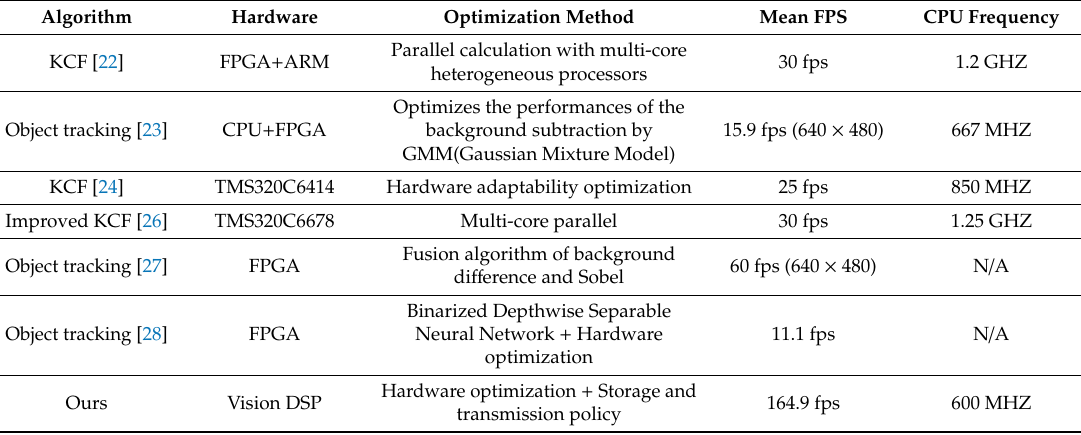
Table 4. Speed performance